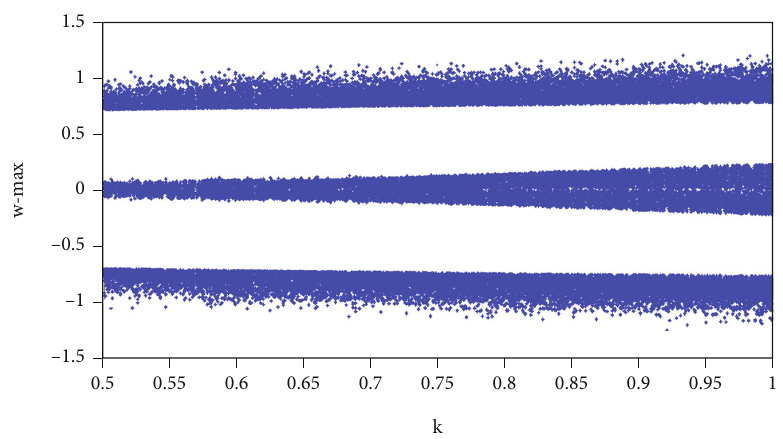
Figure 11: Bifurcation diagram of the LS system (5) for parameter k in the interval [0.5, 1].